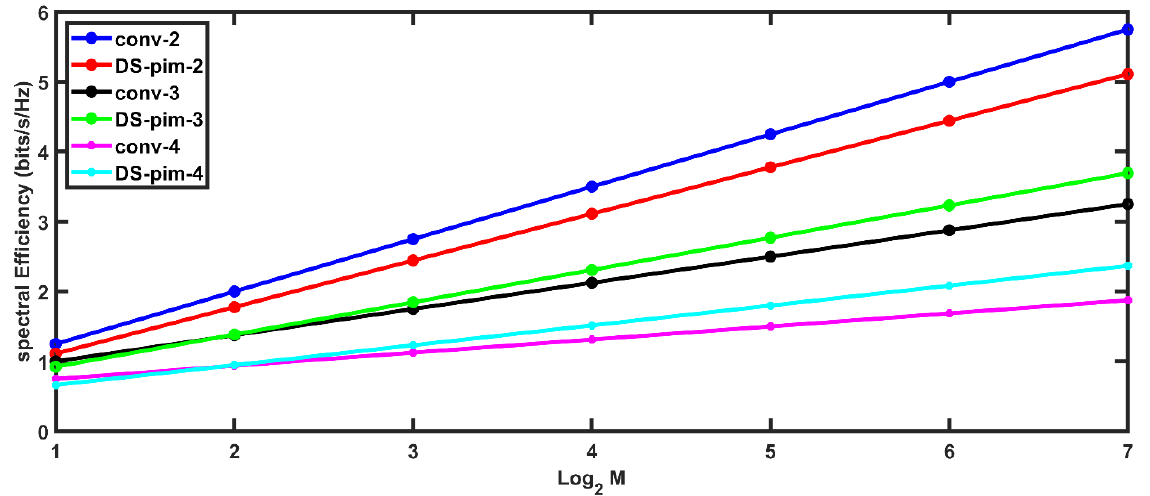
Figure 9. Spectral fficiency vs. modulation order, for conventional and DS-PIM-based SIM OFDM (index word lengths of 2-bits, 3-bits and 4-bits) where K = 3.